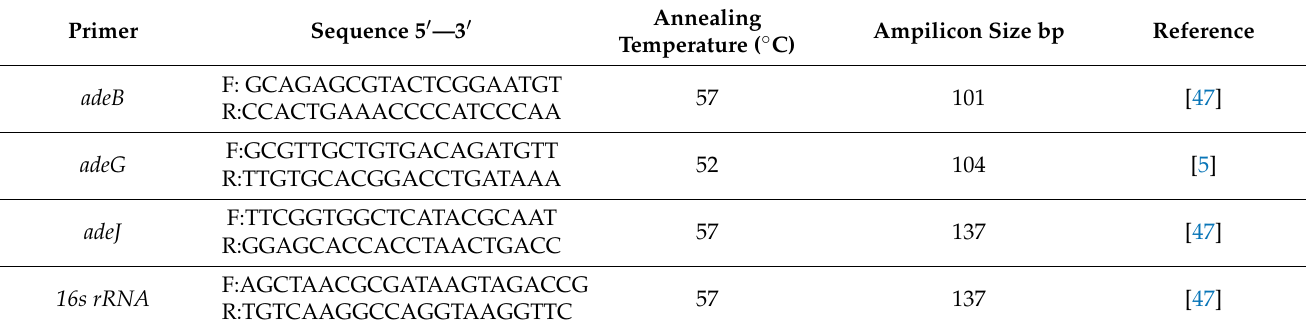
Table 4. Oligonucleotides sequences and annealing